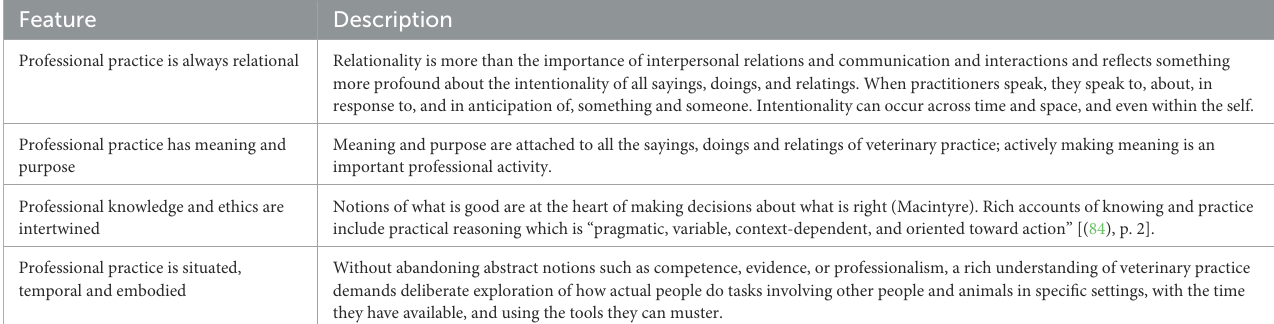
TABLE 1 Key features of professional